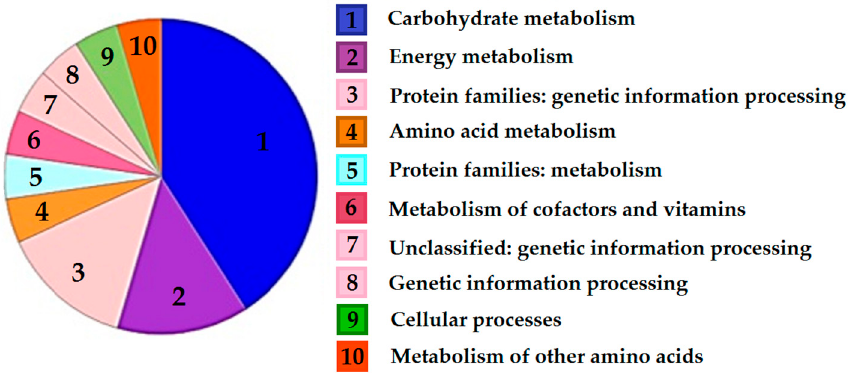
Figure 2. Results of the ortholog annotation of the proteins that were regulated in the Sb. thermotolerans cells in response to the pyrite-arsenopyrite concentrate, using KOALA (KEGG Orthology and Links Annotation) tools [47]. The pie chart shows the relative contribution of the functional categories of regulated proteins. The categories are numbered (1–10) and shown in different colors, according to KEGG color codes.